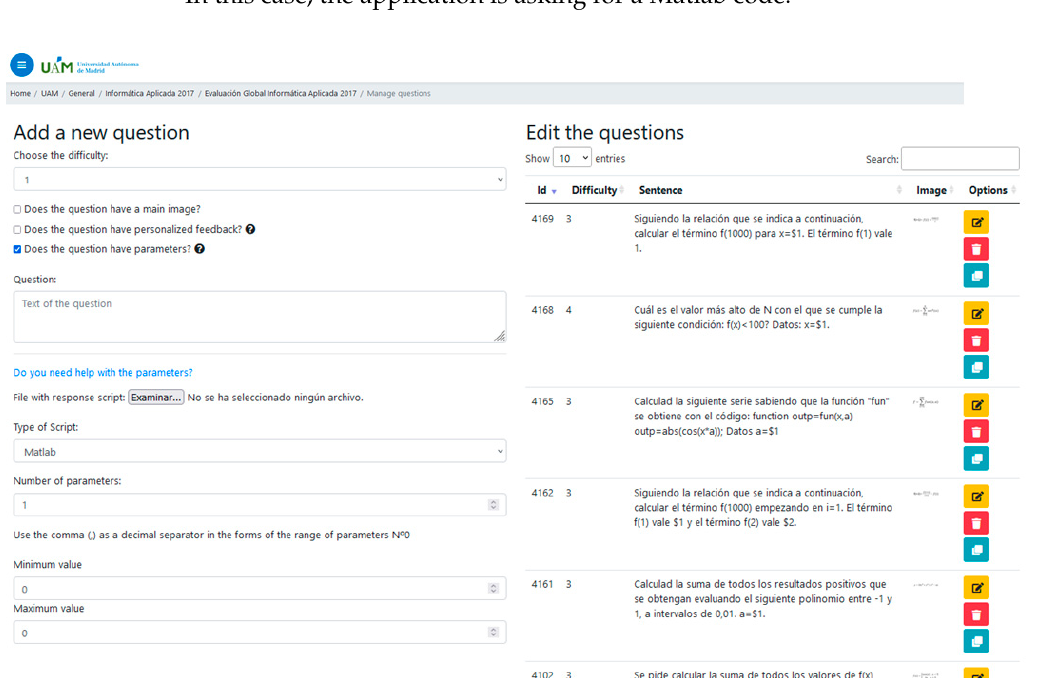
Figure 1. e-valUAM interface for teachers, showing the questions management window.